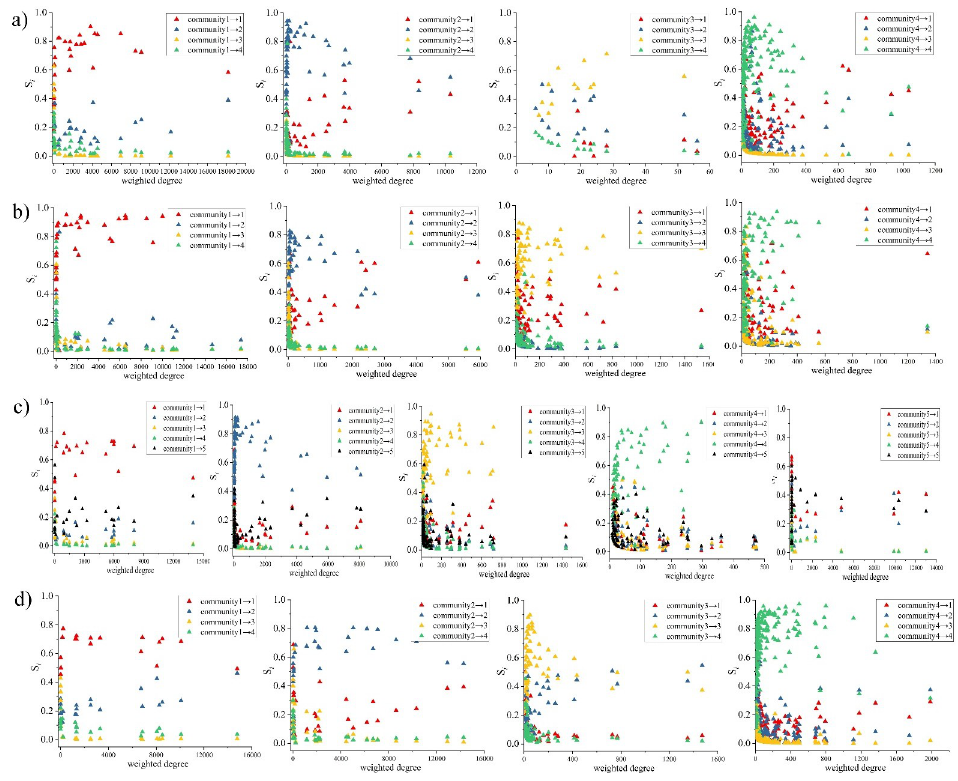
Fig 12. TZs interaction intensity between communities. a) peak1 ; b) peak2 ; c) peak3 ; d) peak4 .